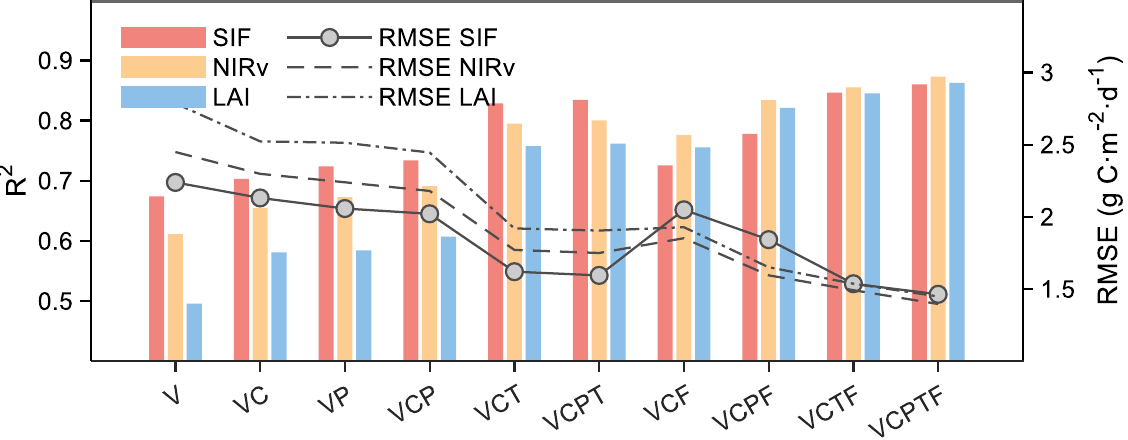
Figure 5. The performance of RF models using different combinations of predictors. The hyper- parameters of the models using other combinations of inputs were consistent with the optimal model. The left and right axes represent the mean predicted R2 and RMSE values of the models over 50 repetitions, with negligible differences each time. The variables used to develop the GPP estimation models are represented by the combination of their abbreviations, i.e., VIs (V), CO 2 (C), PFT (P), plant traits (T), and climate factors (F) (Table S2). For example, ‘VCT’ denotes the RF GPP model that used VIs, CO 2 , and plant traits as input.